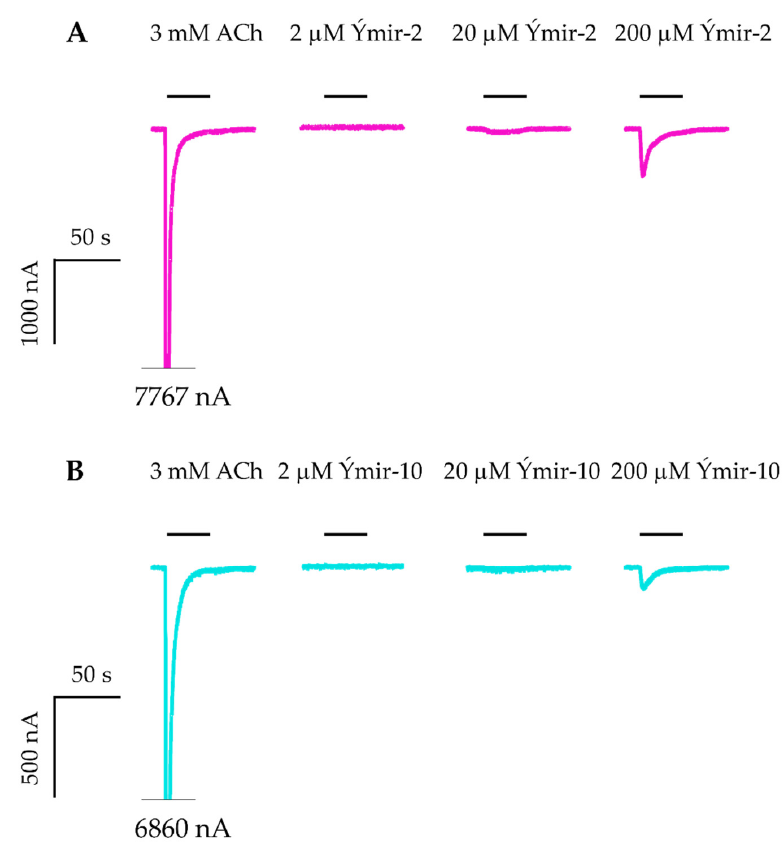
Figure 7. Evaluation of compounds as agonists. Representative current traces for ACh, Ý mir-2 ( 7 ) ( A ) and Ý mir-10 ( 15 ) ( B ) at α 7 nAChRs expressed in Xenopus oocytes. Cells were subjected to two-electrode voltage-clamp electrophysiology experiments where the oocyte membrane potential was clamped at − 60 mV. The representative traces were baseline subtracted. Bars above the traces represent the application periods and the respective test solution concentrations are indicated above them. Note that the majority of the washing periods (3 min) between each trace are omitted in the figure.